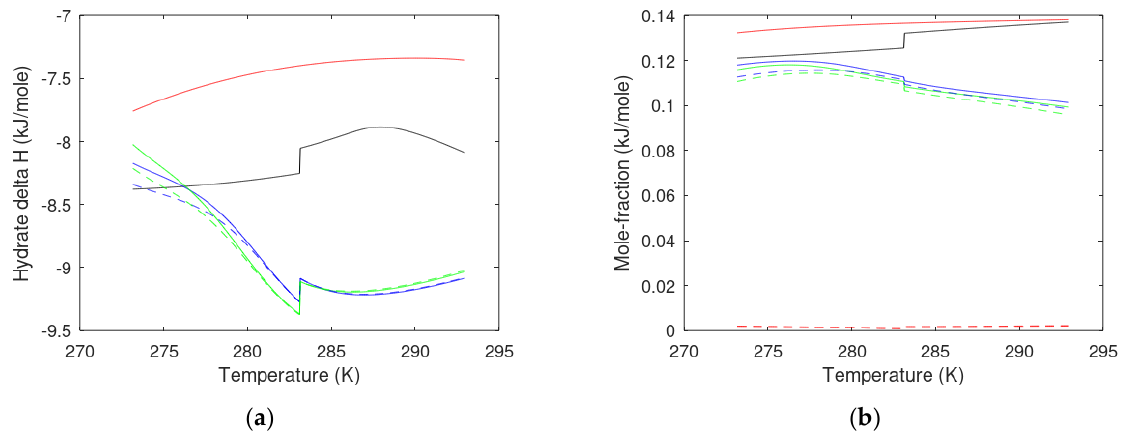
Figure 8. ( a ) Enthalpy of hydrate formation in units of kJ/mole hydrate along temperature pressure hydrate stability limits in Figure 6 (a) Red curve is CH 4 hydrate and black curve is CO 2 hydrate. Blue curve is for hydrate from 80 mole% CO 2 and 20 mole% N 2 . Green curve is for hydrate from 70 mole% CO 2 and 30 mole% N 2 . Blue dashed curve is for hydrate from 80 mole% CO 2 , 19 mole% N 2 , and 1 mole% CH 4 . Green dashed curve is for hydrate from 70 mole% CO 2 , 29 mole% N 2 , and 1 mole% CH 4 . ( b ) Mole ‐ fractions CO 2 and CH 4 in hydrate. Red curve is CH 4 hydrate and black curve is CO 2 hydrate. Blue curve is CO 2 mole ‐ fraction for hydrate from 80 mole% CO 2 and 20 mole% N 2 . Green curve is for CO 2 mole ‐ fraction in hydrate from 70 mole% CO 2 and 30 mole% N 2 . Blue dashed curve is CO 2 mole ‐ fraction for hydrate from 80 mole% CO 2 , 19 mole% N 2 , and 1 mole% CH 4 . Green dashed curve is CO 2 mole ‐ fraction for hydrate from 70 mole% CO 2 , 29 mole% N 2 , and 1 mole% CH 4 . Upper red dashed curve is CH 4 mole ‐ fraction in hydrate from 70 mole% CO 2 , 29 mole% N 2 , and 1 mole% CH 4 and lower red dashed curve is CH 4 mole ‐ fraction in hydrate from 80 mole% CO 2 , 19 mole% N 2 , and 1 mole% CH 4 .